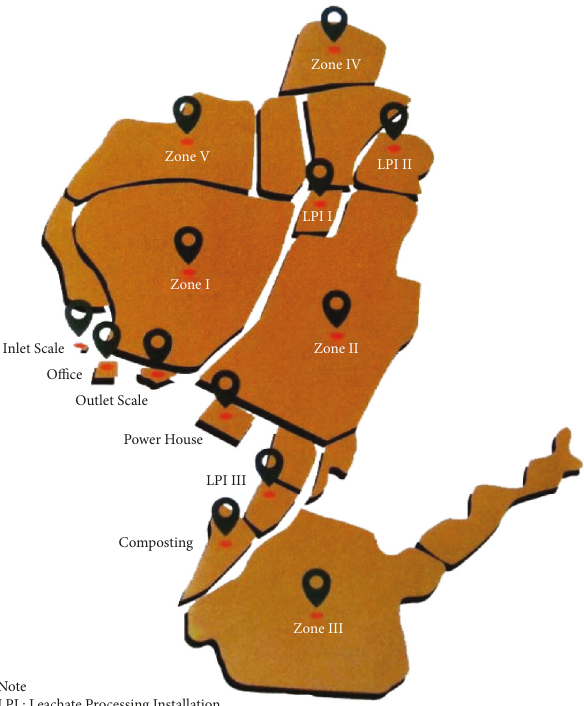
Figure 1: Map of Bantargebang landfill. Source: Integrated Waste Management Unit, the Environmental Services of DKI Jakarta Provincial Government, 2018